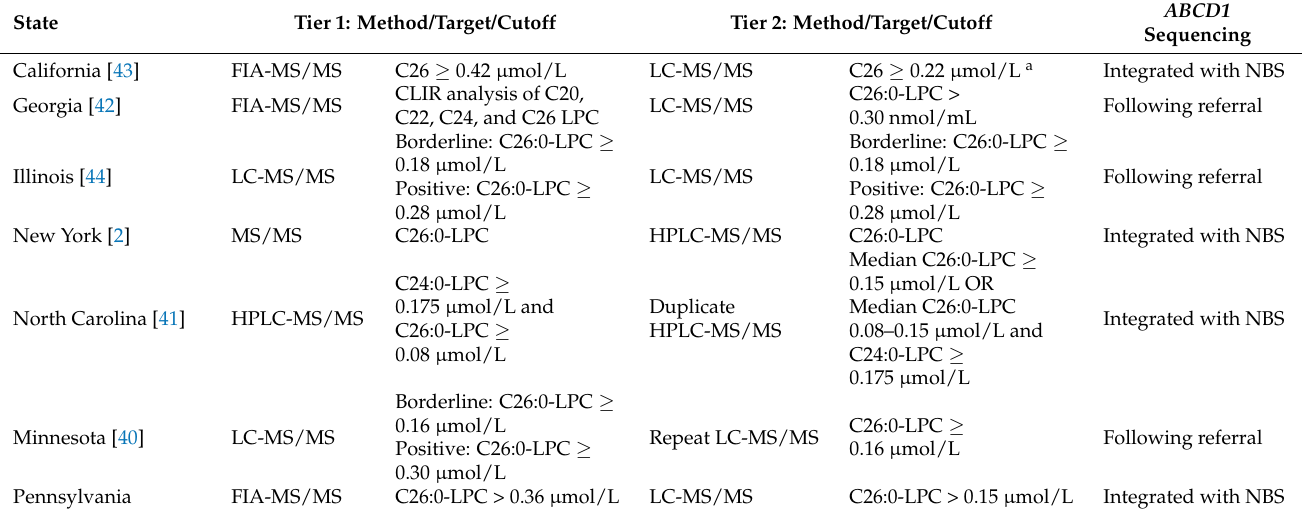
Table 3. Comparison of newborn screening strategies for X-ALD across seven U.S. states. All states employed a two-tier strategy for identifying infants requiring biochemical genetics referrals. Sequencing of the ABCD1 gene was performed either prior to the referral by the NBS laboratory as a “third-tier” screen or ordered clinically by the referral provider. FIA = flow injection analysis; LC = liquid chromatography; HPLC = high-performance liquid chromatography; MS/MS = tandem mass spectroscopy.